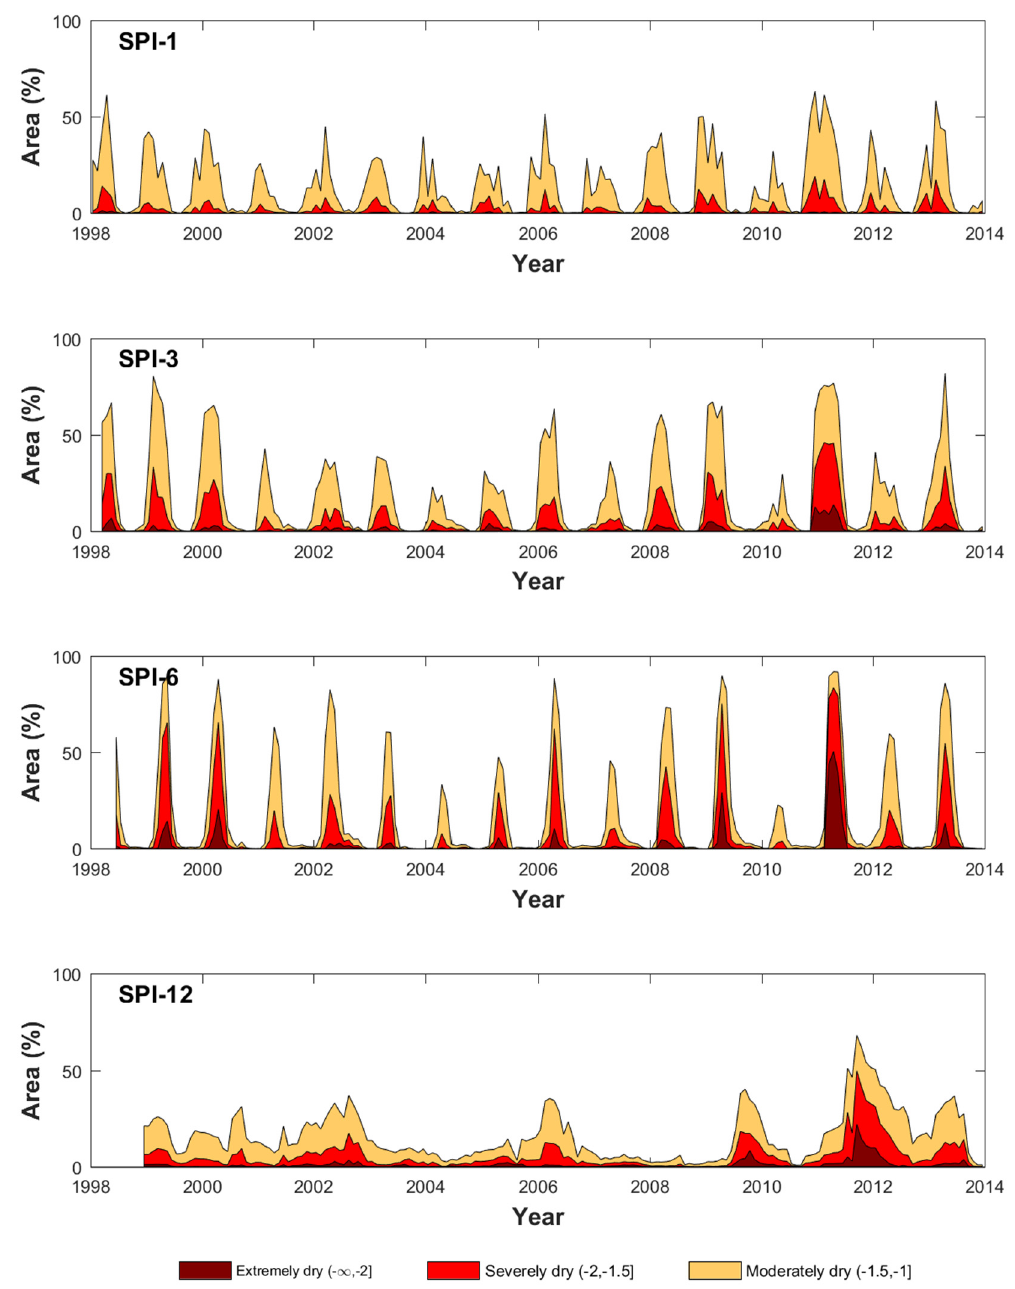
Figure 9. TRMM 3B42-based temporal evolution (1998–2013) of Mexico’s terrestrial surface affected by drought conditions (moderate, severe and extreme) and for different SPI timescales (one, three, six and twelve months).